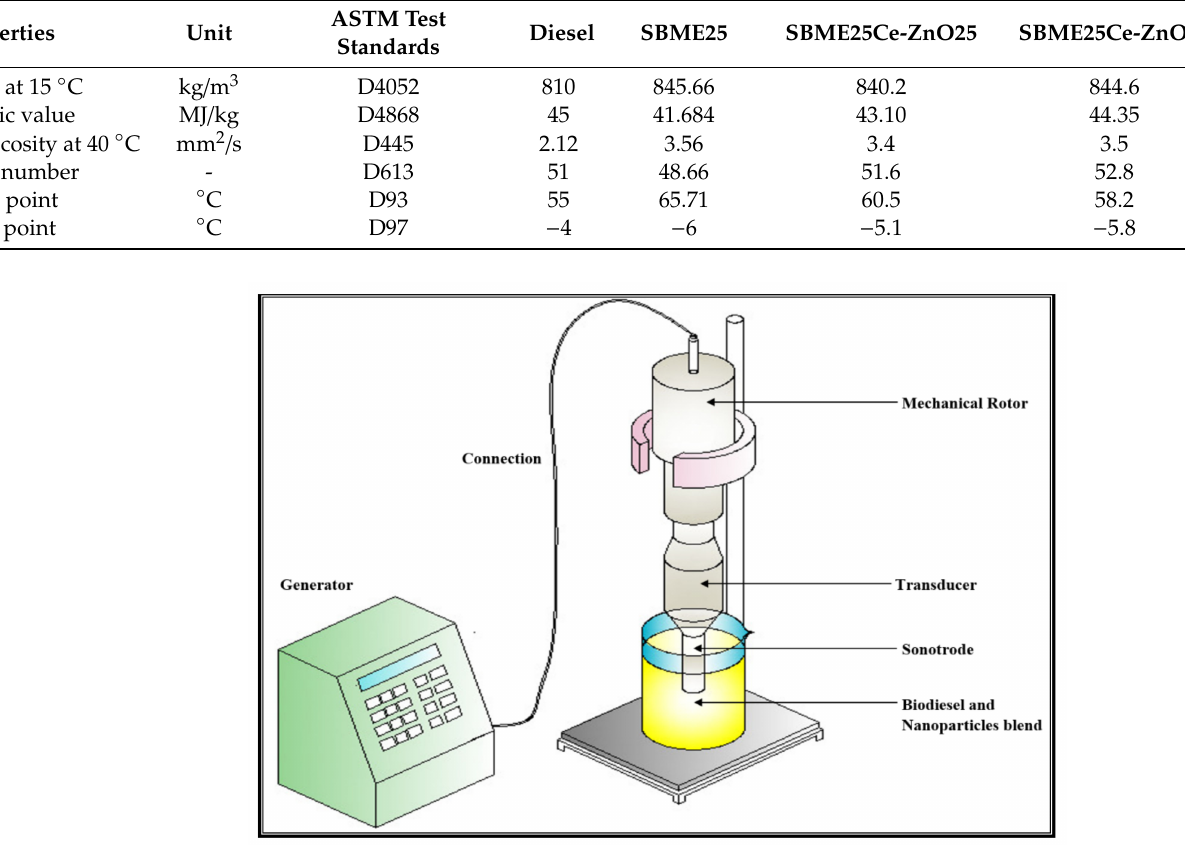
Figure 5. Schematic representation of probe